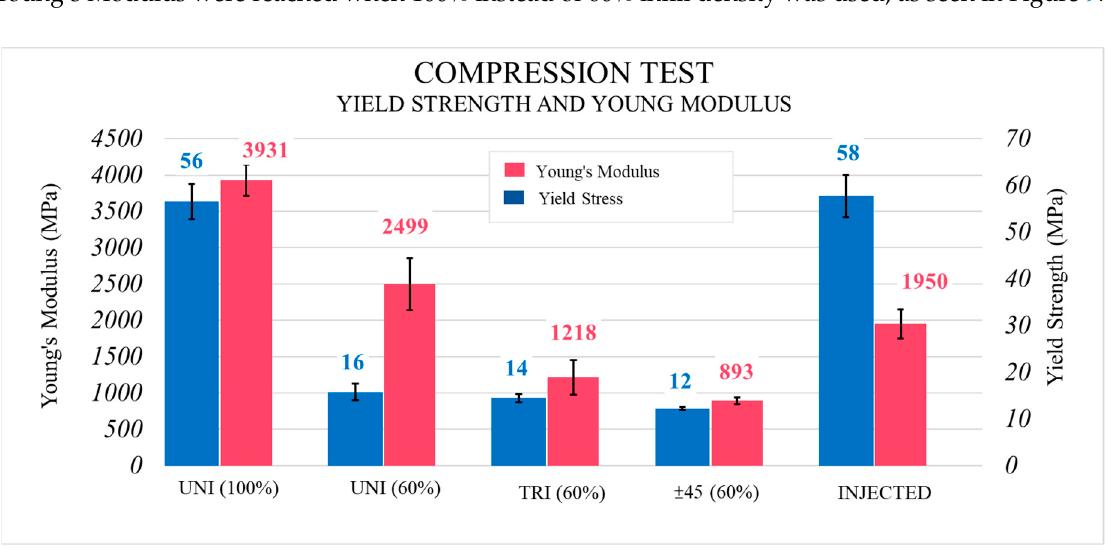
Figure 9. Compression test. Results obtained for yield strength, tensile strength and Young's Modulus of the injected and 3D printed samples.